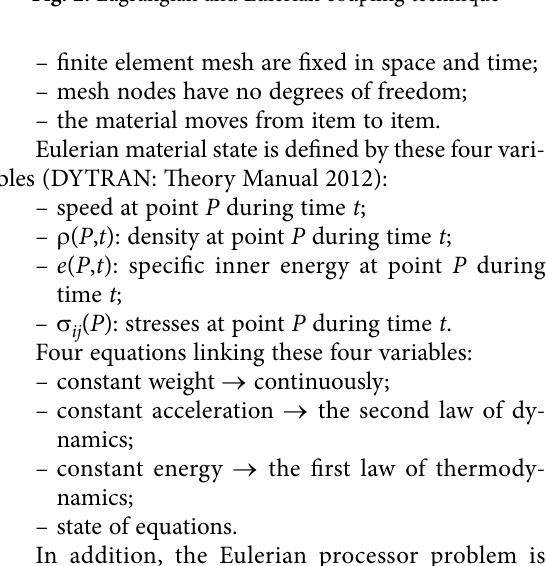
Fig. 2. Lagrangian and Eulerian coupling